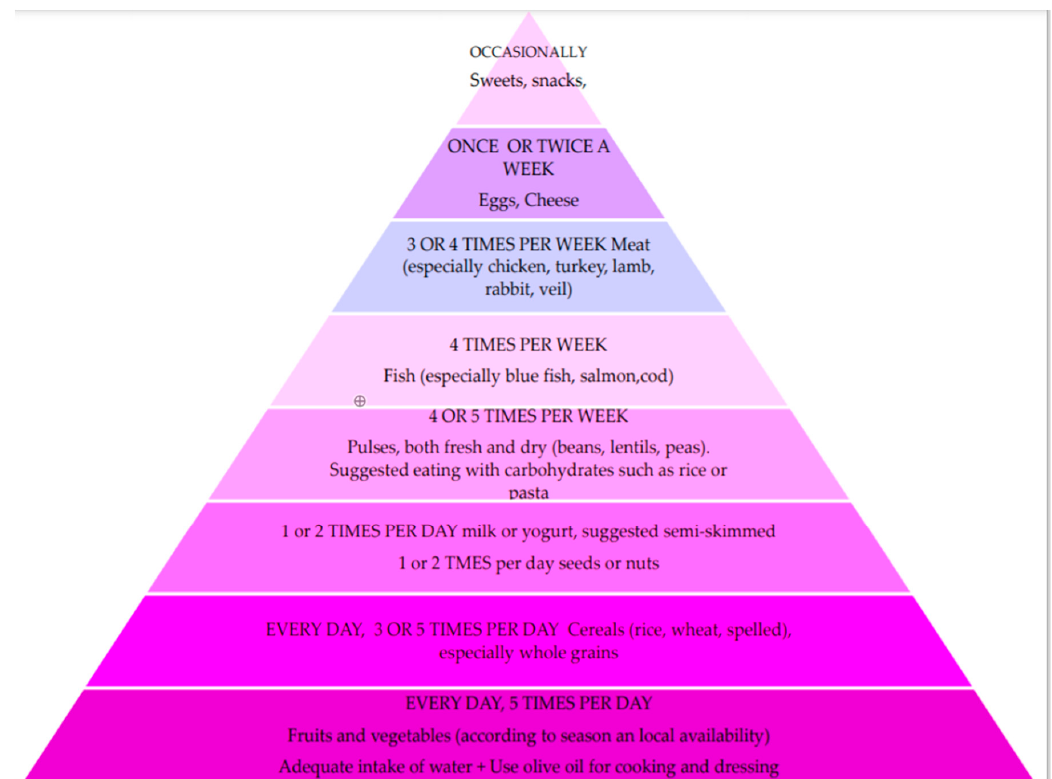
Figure 1. The Nutritional Diet Pyramid for children, modified from Giovannini et al. [57]. The possibility of using functional foods is included; in this regard, foods containing added plant sterols/stanols, psyllium-enriched cereals, garlic extract, omega-3 fatty acids and soy proteins, have been evaluated in small studies in children with hypercholesterol- emia. Anyway, no strong recommendations on functional foods utilization in childhood and adolescence are yet available. [11]. In the 2016 European Society of Cardiology (ESC) and EAS guidelines for the management of dyslipidemias, plant sterols/stanols are indi- cated for adults and children (>6 years) with FH [59]. In Italy, a heart-healthy diet should be in accordance with the Italian Society of Human Nutrition reference values (LARN) [55]. A daily recommended distributions of meals is shown in Figure 2. Recommended macronutrient intake for school-age children are shown in Table 2.